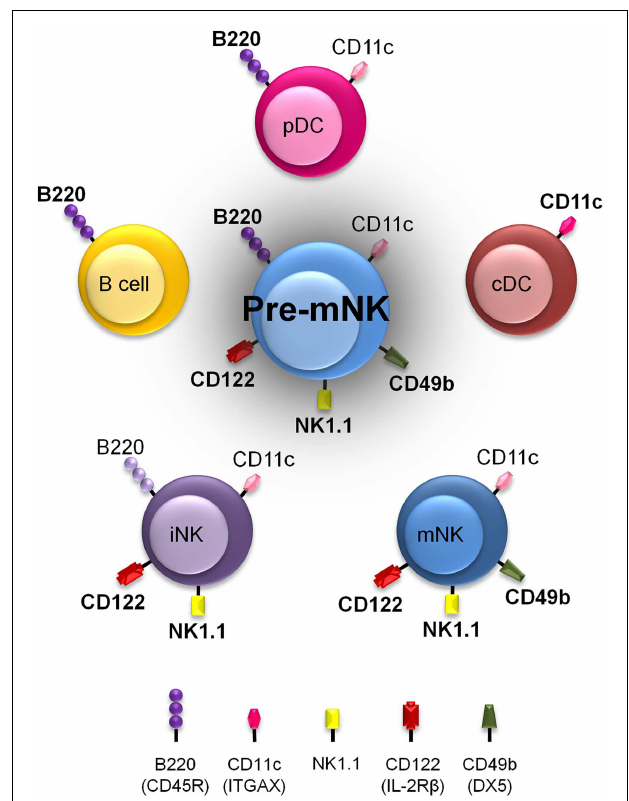
FIGURE 1 | Pre-mNK cells share phenotypic expression with a variety of other immune cells . Murine immune cell types harboring cell surface antigens also present on pre-mNK cells are depicted.The intensity in color represents the level of expression. Note that a combination of at least three cell surface antigens, namely CD11c, B220, and CD49b, must be used to clearly distinguish pre-mNK cells from other immune cell types.This shared phenotypic character of pre-mNK cells increases the risk of potential cellular contaminants during the isolation